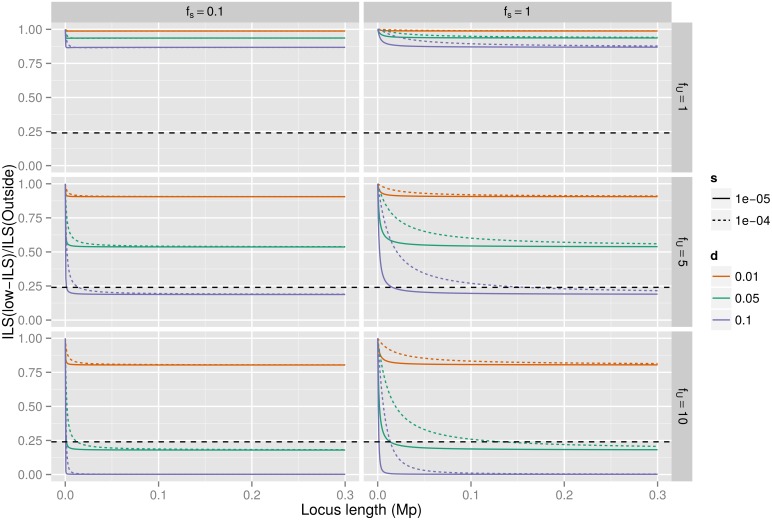
Background selection and ILS.The plots show the ratio of ILS inside the low ILS regions compared to that outside the regions, assuming speciation times of 5.95 mya and 3.7 mya, 20 year generations and that the neutral X effective population size is three quarters that of the autosomes. The colors correspond to different choices of which fraction of mutations are deleterious, varying from 1% to 10%. The different columns correspond to different choices of selection within the low ILS regions—set to either the same as outside or one tenth of the selection strength outside—and different rows show how much more of the regions is under selection compared to outside, either the same or a factor of five or ten. Selection strength is set to either 1e-4 (dotted curve) or 1e-5 (solid curve). The horizontal dashed line represents the observed reduction in ILS of 24% (from 21% ILS outside low-ILS regions to the <5% ILS of low-ILS regions).